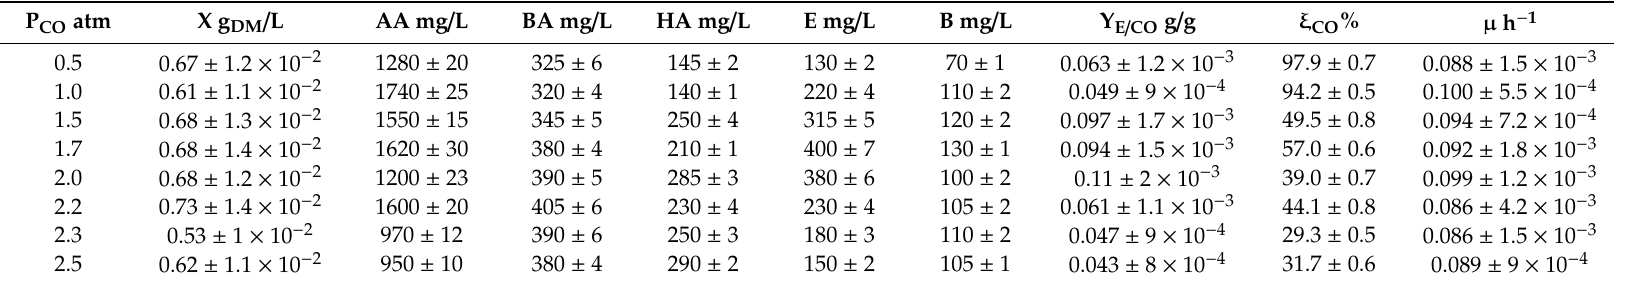
Table 1. Data from the fermentation tests carried out by setting the liquid volume at 55 mL (V L / V G = 0.28). X, cell concentration; AA, acetic acid concentration; BA, butyric acid concentration; HA, hexanoic acid concentration; E, ethanol concentration; B, butanol concentration; Y E / CO , CO-to-ethanol yield coe ffi cient; ξ CO , CO conversion degree; µ , specific cell growth rate.